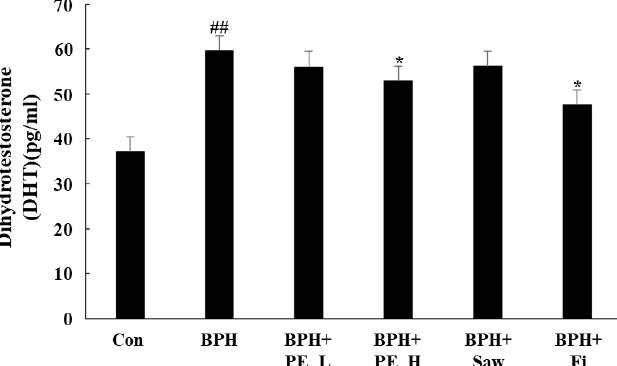
Figure 3. E ff ect of PE on the levels of DHT in serum. Individual data were obtained using a DHT enzyme-linked immunosorbent assay (ELISA). Note: Con, normal control group; BPH, TP (3 mg / kg / d) / corn oil injection; BPH + PE_L; BPH + PE_L, 100 mg / kg of PE treated BPH group; BPH + PE_H, 200 mg / kg of PE treated BPH group; BPH + Saw saw palmetto extract treated BPH group; BPH + Fi, Fi treated BPH group. Data are presented as mean ± SEM ( n = 6). Significant di ff erences at ## p < 0.01 compared with the control group. Significant di ff erences at * p < 0.05 compared with the BPH group.